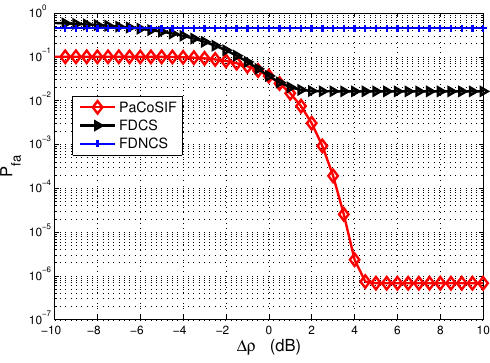
Figure 5. The false alarm rate of the fused decisions in spectrum-heterogeneous environments.